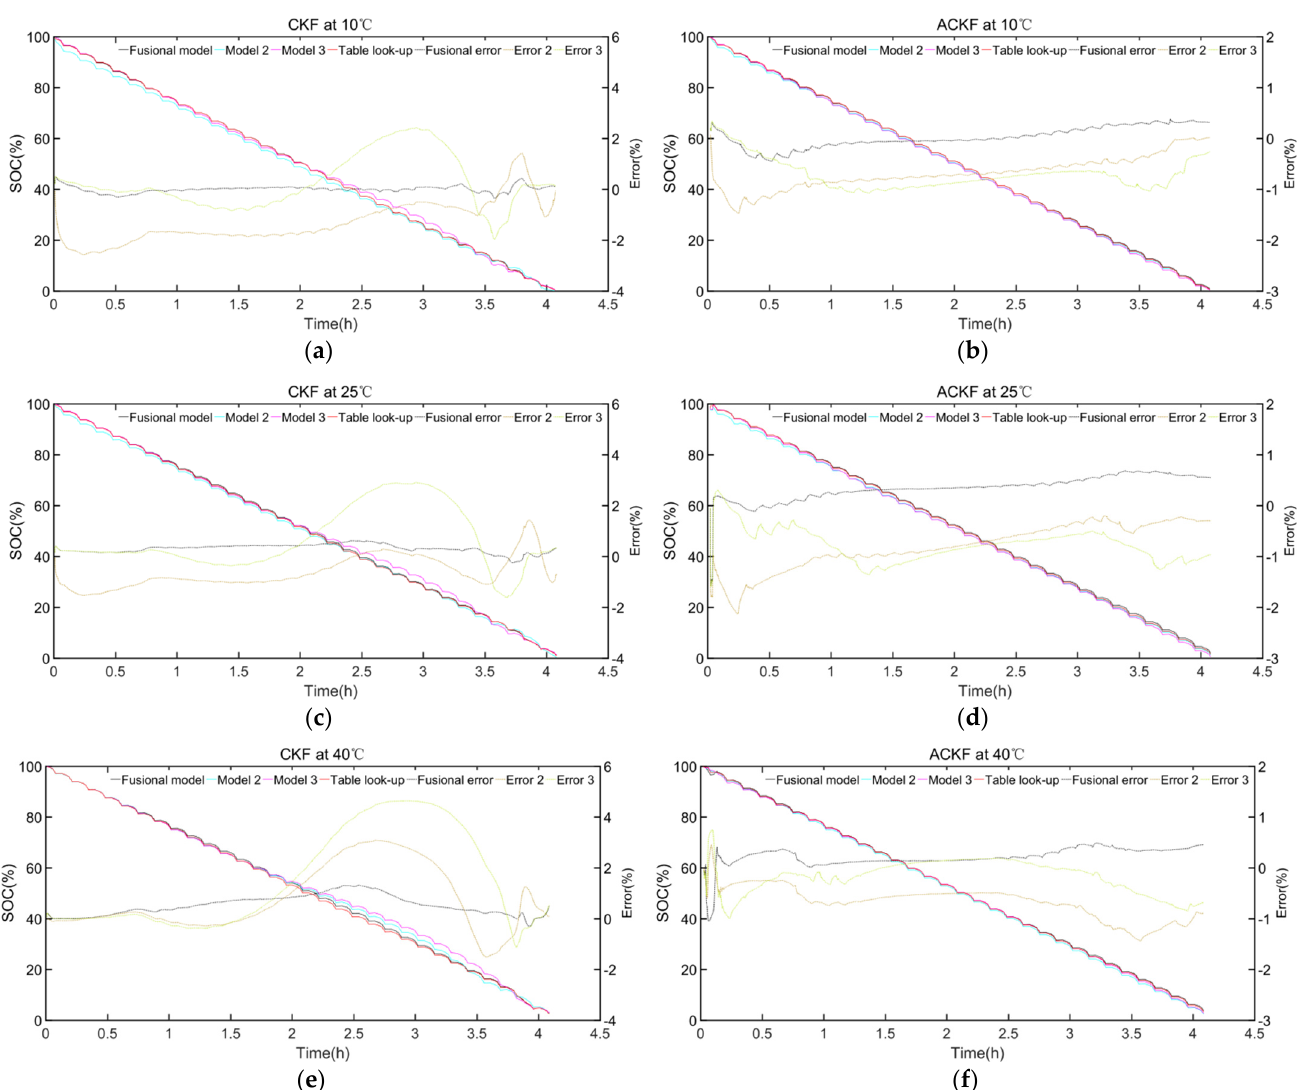
Figure 11. SOC estimation results for NMC battery by using: ( a ) CKF at 10 °C. ( b ) ACKF at 10 °C. ( c ) CKF at 25 °C. ( d ) ACKF at 25 °C. ( e ) CKF at 40 °C. ( f ) ACKF at 40 °C.